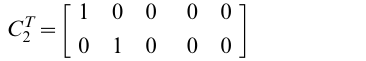
Figure 7 (top panel) plots SDT versus IMO log Bayes factors for voxels in slice z ~{ 11 mm . This shows good agreement, except at large values of IMO log Bayes factor. The overall correlation is r ~ 0 : 993 . The plot shows a similar effect to that observed in Figure 2, suggesting that the discrepancy may be due to inconsistent estimates of observation noise precision. We then repeated the above analysis but with the contrast now testing for the main effect of